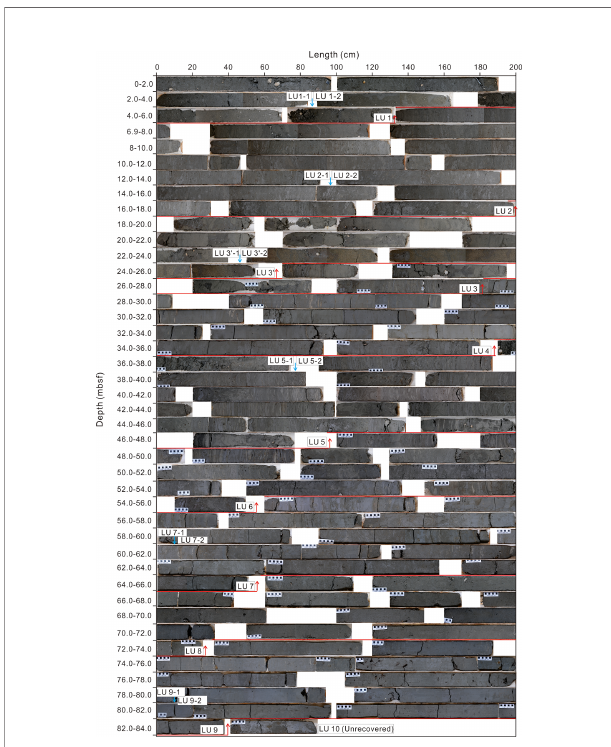
FIGURE 3 | The photos showing the sediment characters and lithological units of borehole SFK-1. mbsf, meters below sea fl oor. The red and blue arrows indicate the boundaries of depositional units and subunits respectively.